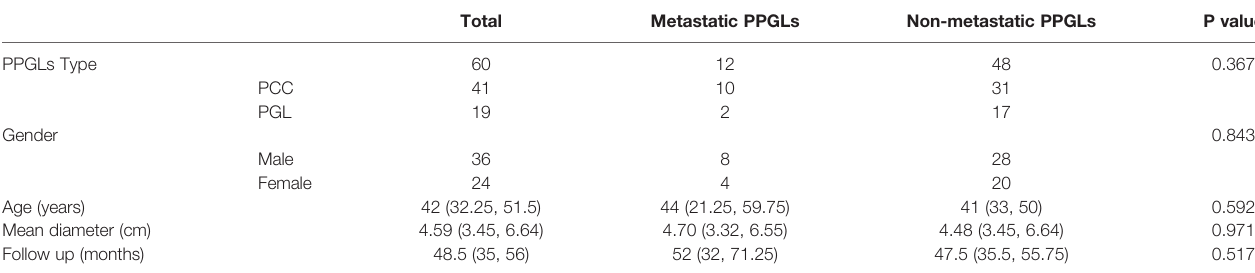
TABLE 1 | The patients ’ characteristics and follow-up data of PPGLs.